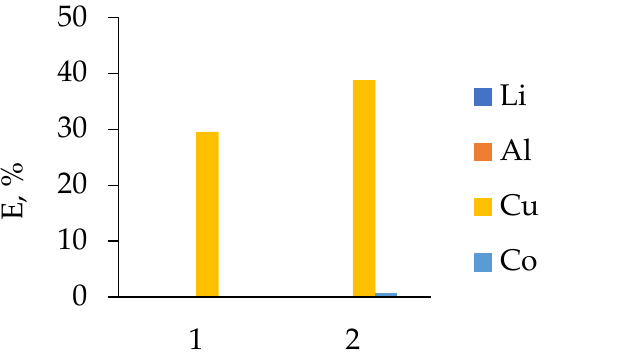
Figure 4. Extraction of metal ions with HDES 1 from the LIB 1 leaching solution at O/A phase ratios of: 1—1/5; 2—1/1.